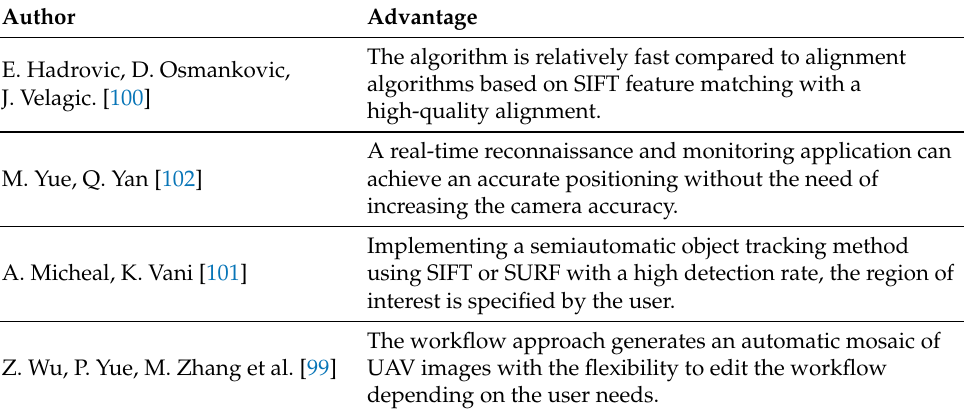
Table 6. SURF applied on